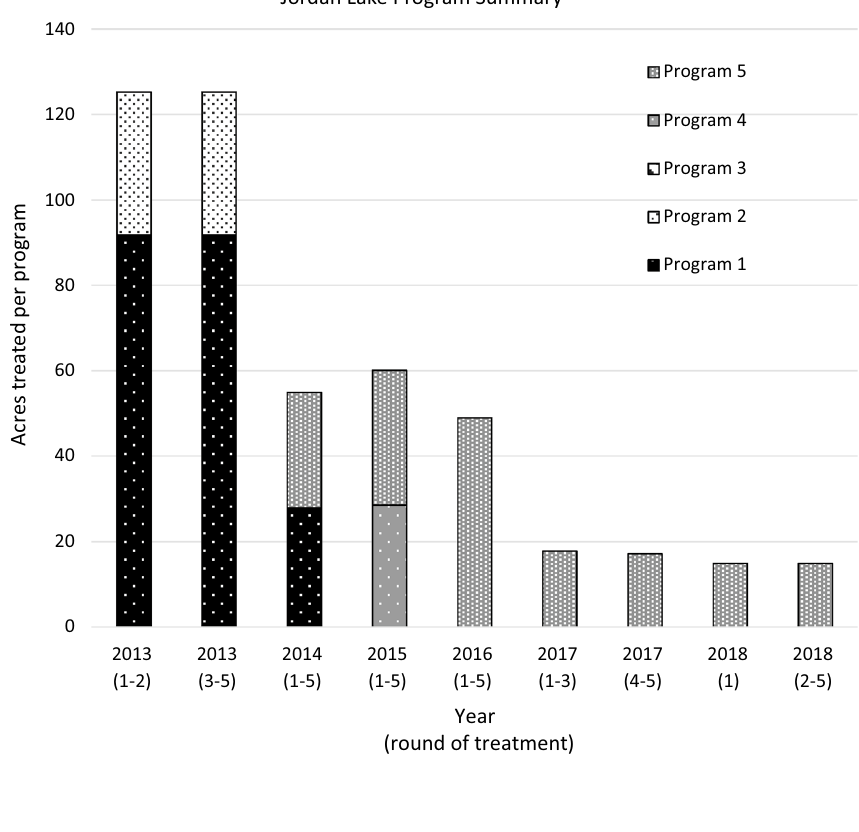
Fig. 4 Surface acres of nuisance L. wollei infestations treated with each algaecide treatment program in Lake Mitchell through